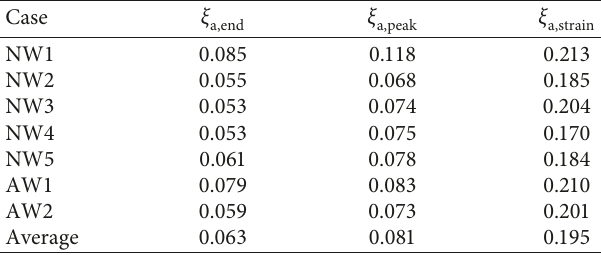
Table 7: Additional EDRs obtained by different approaches.